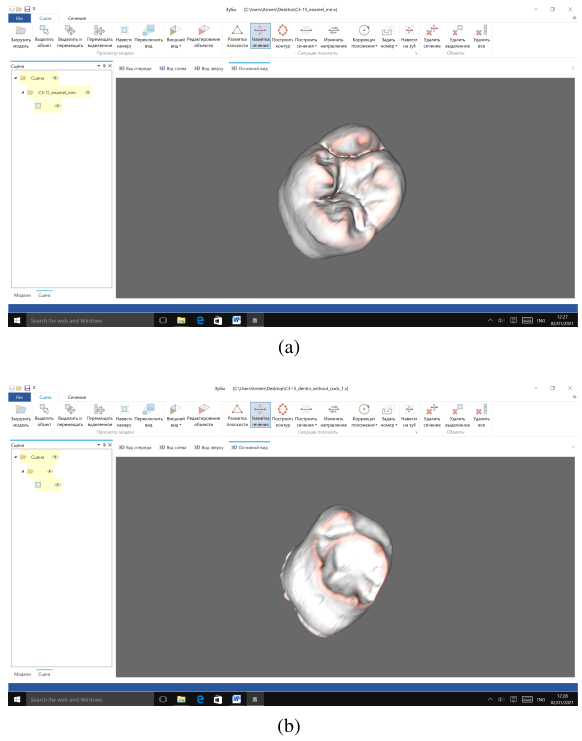
Figure 1. 3d reconstructions of enamel (a) and dentin (b)